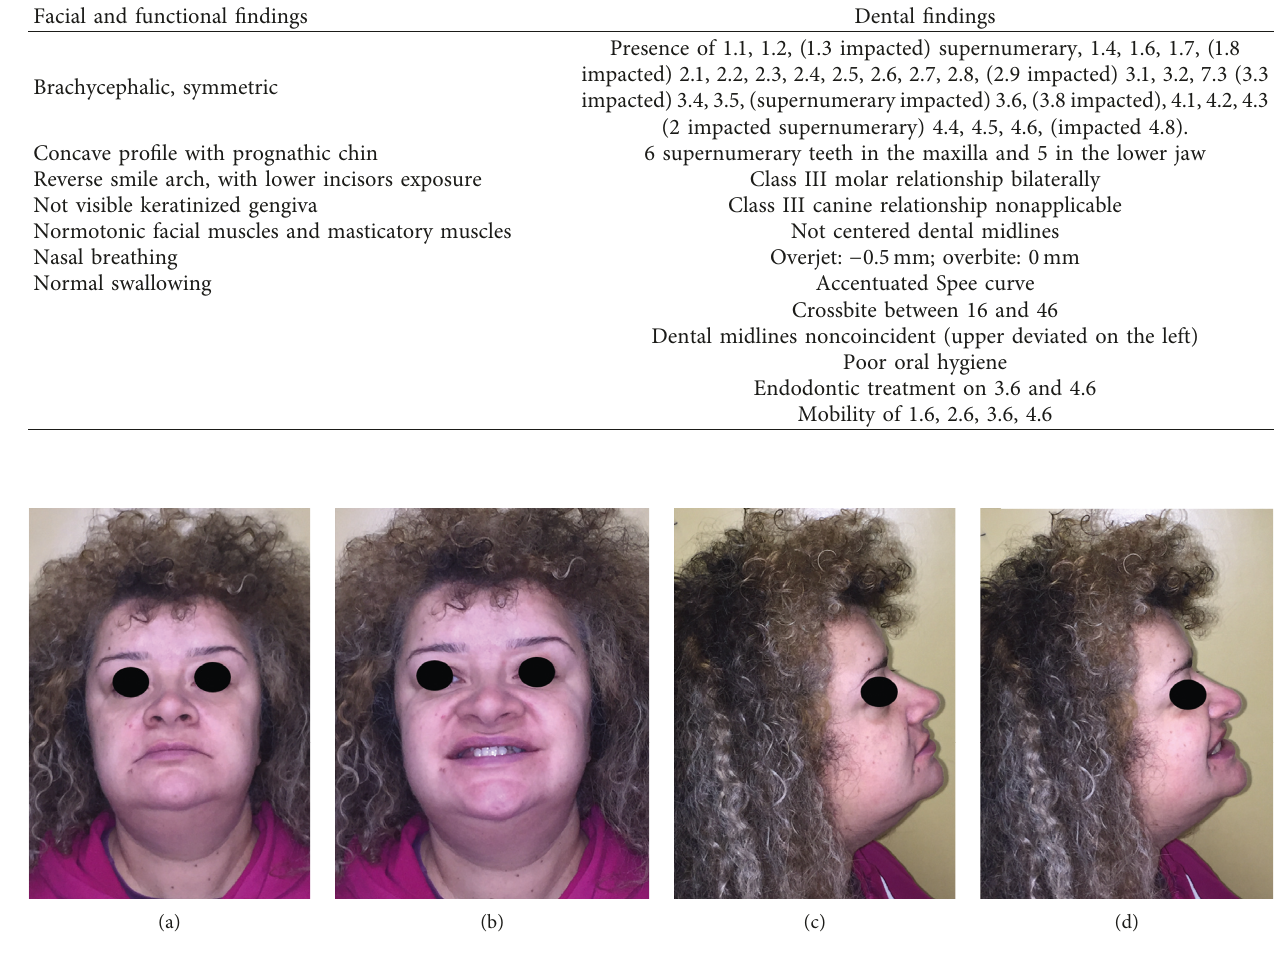
Table 13: Case 3: orthodontic diagnosis summary.